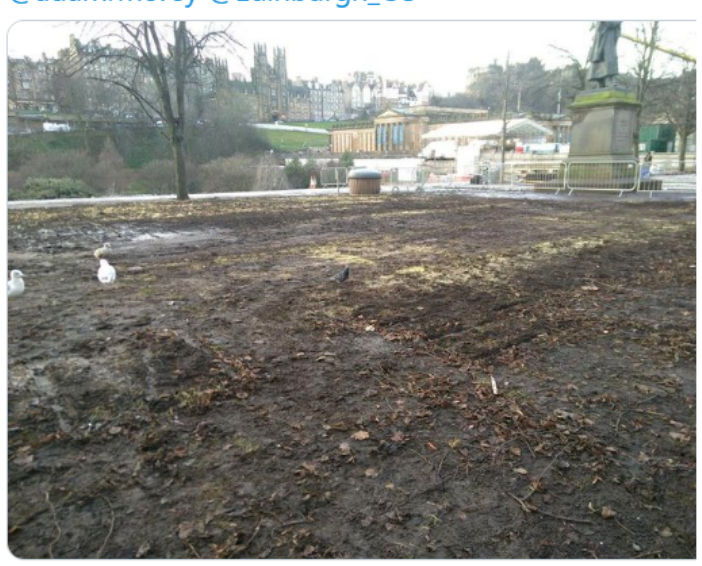
Figure 5. Aftermath of Christmas Markets. Source: Grouse Beater